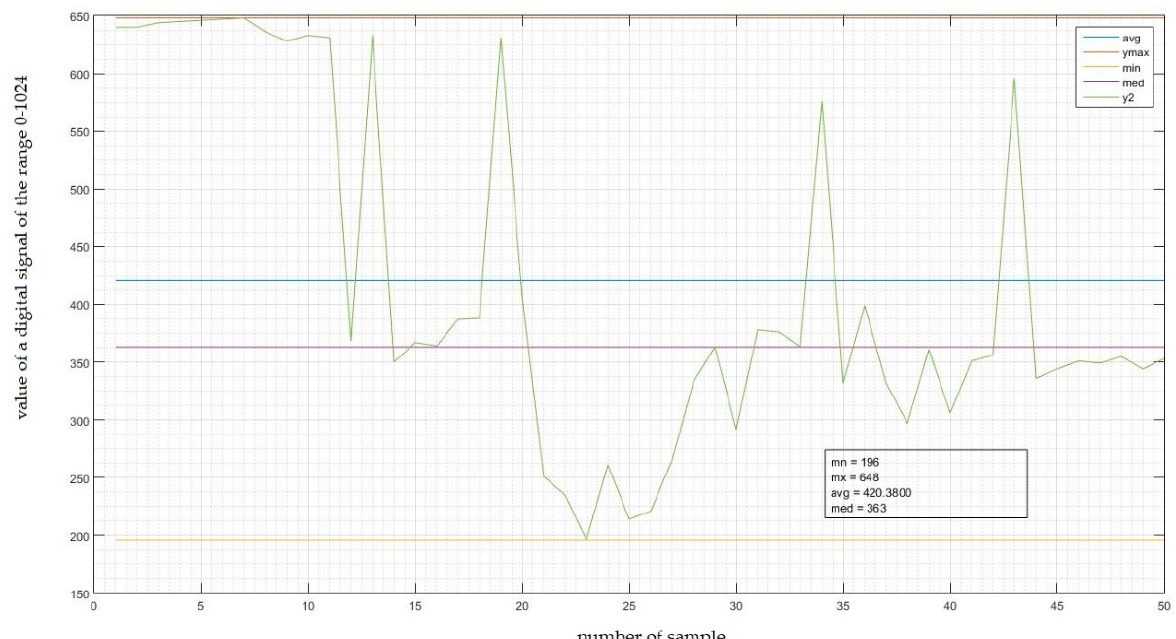
Sensors 2022 , 22 , x FOR PEER REVIEW